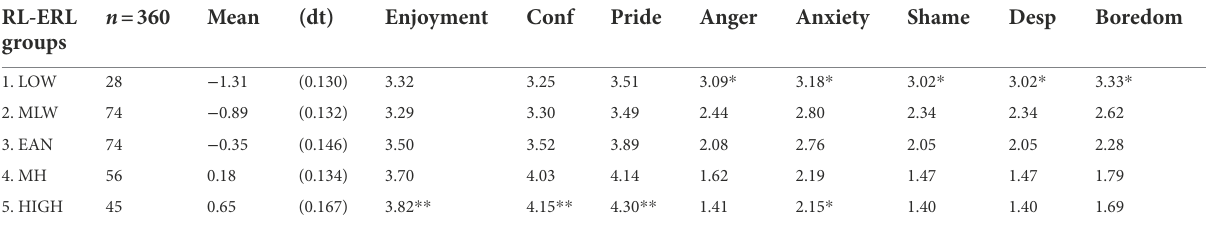
TABLE 15 Descriptive statistics for the groups formed ( n = 360). RL-ERL groups